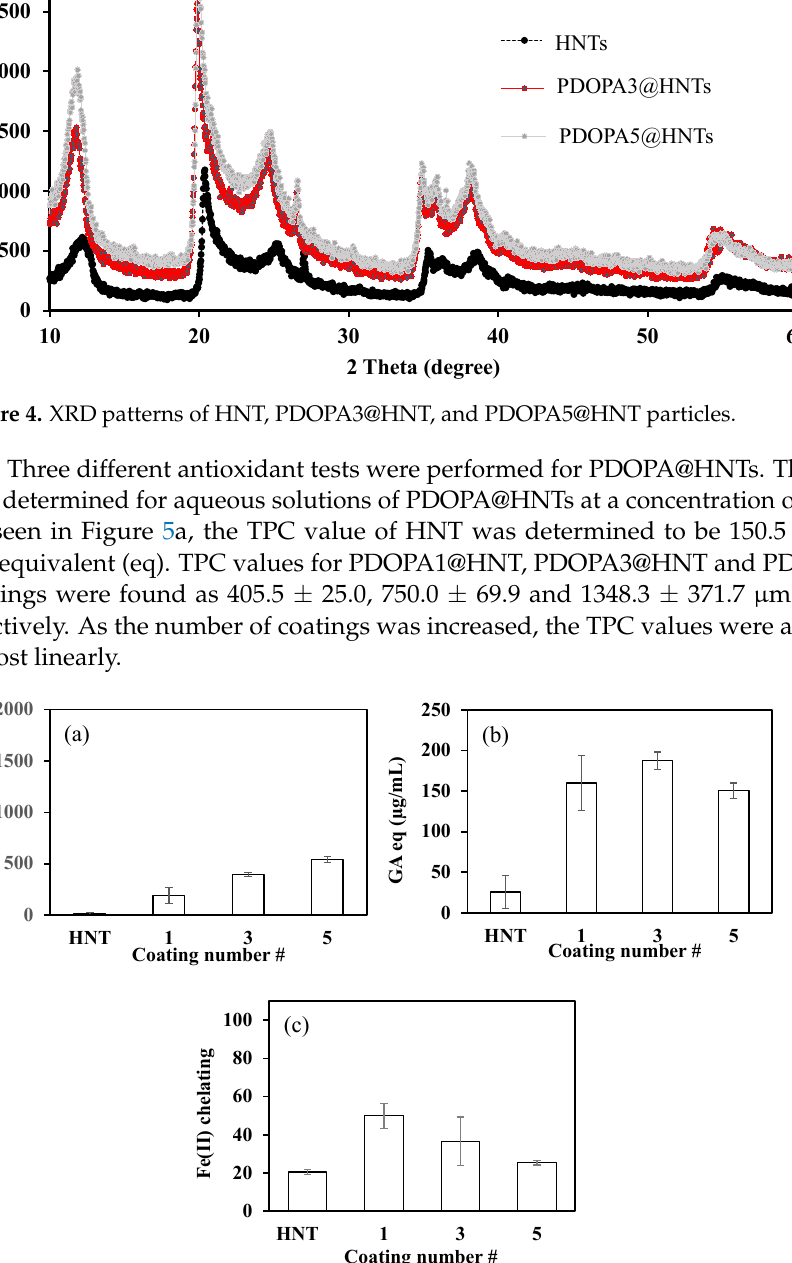
Figure 5. ( a ) TPC values, ( b ) TFC values, and ( c ) Fe(II) chelating capacities (%) of HNT and PDOPA@HNT particles. The TFC values for PDOPA@HNT coatings are given in Figure 5b. The highest value was determined as 187.3 ± 10.8 µg/mL GA equivalent in PDOPA3@HNTs. In PDOPA5@HNTs, it was found as 150.3 ± 9.4 µg/mL GA eq., whereas the neat HNT had a TFC value of 25.6 ± 20.3 µg/mL GA eq. The reason why PDOPA3@HNT had a higher value than PDOPA5@HNT may be due to the aggregation of PDOPA layers as the number of coatings increased. On the other hand, the percentage of Fe(II) chelation is given in Figure 5c, and it was observed that the chelating capacity decreased with the increase in the number of DOPA